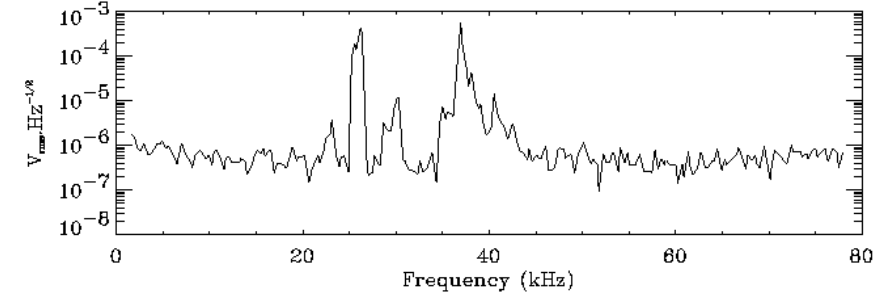
Fig. 11. A single frequency spectrum derived from an active sounding sweep, at 13:29:51UT, for the event shown in Fig. 10.